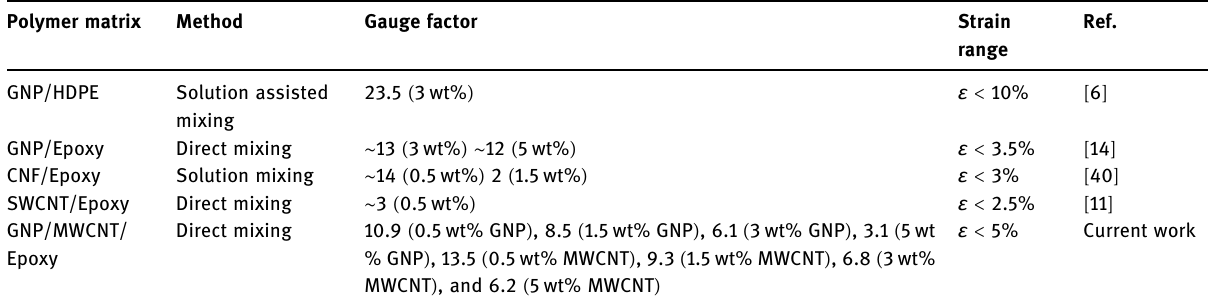
Table 4: Comparison of carbon - based ( GNP and MWCNT ) self - sensing composite Polymer matrix